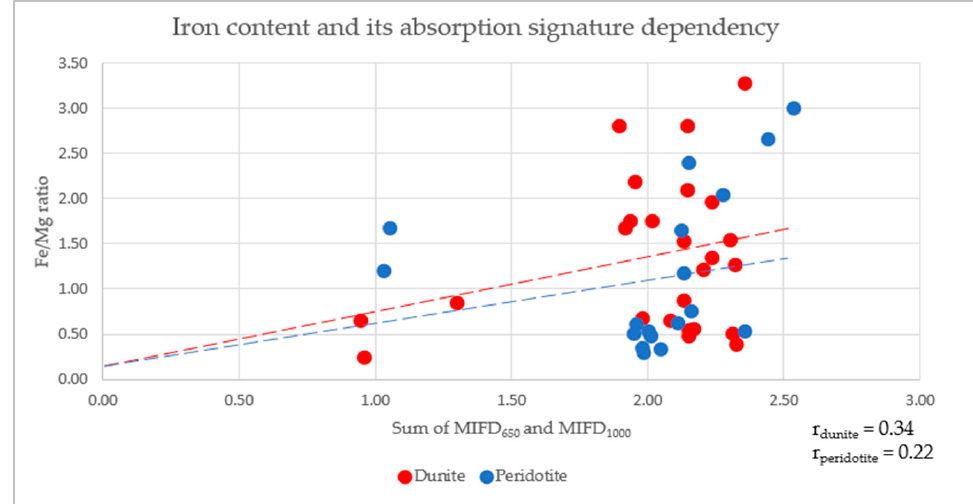
Figure 9. Fe/Mg ratio versus MIFD of summed ferrous and ferric iron absorption depths for dunites (red) and peridotites (blue) calculated for HyMap spectral resolution in the laboratory. r values represent the correlation coefficients for each lithology. Dashed lines show the fitted linear trendlines for each lithology with the corresponding color. Result 2—airborne scale: Analogously, ferrous and ferric MIFDs were calculated for airborne HyMap scenes of the ultramafic complex. The Fe/Mg ratio values from rock samples were plotted against the ferric MIFD 650 (Figure 10) and ferrous MIFD 1000 (Figure 11) from HyMap data. Both figures show a robust, increasing linear trend for peridotite with a large correlation coefficient of 0.85 and 0.68) and a more vague decreasing linear trend for dunite (with lower correlation coefficients of − 0.23 and 0.14).